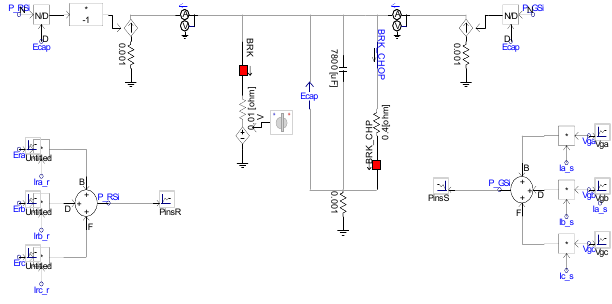
Figure A8. DC voltage controller of the average DFIG model.